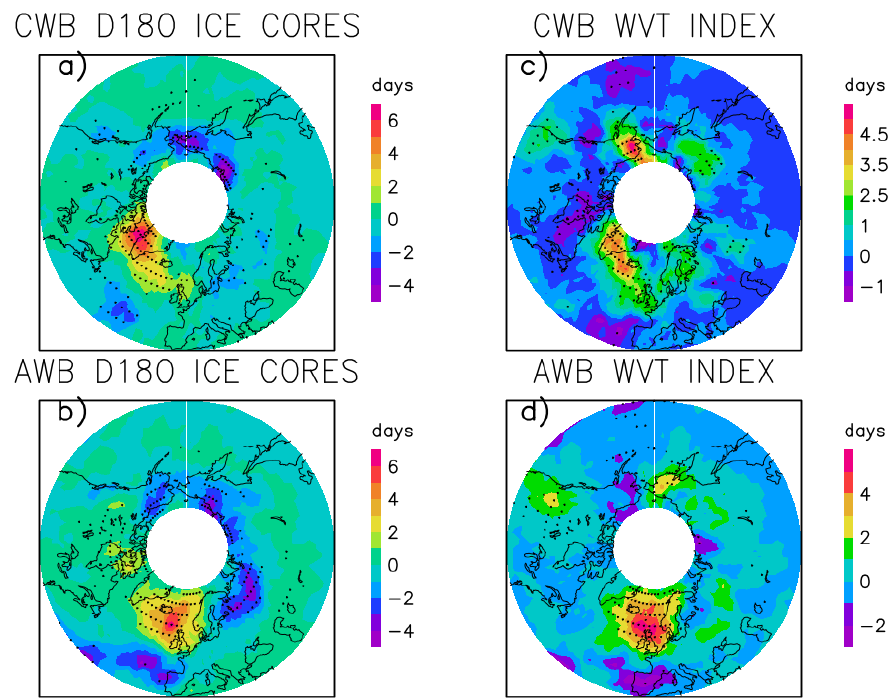
Figure 6. The difference between composite maps of ( a ) CWB and ( b ) AWB frequency of high and, respectively, low ice core δ 18 O winters; ( c , d ), as in ( a , b ), but for extreme WVT index (see text for definition). Regions where the differences are significant at the 90% level or higher are dotted. Units: days.